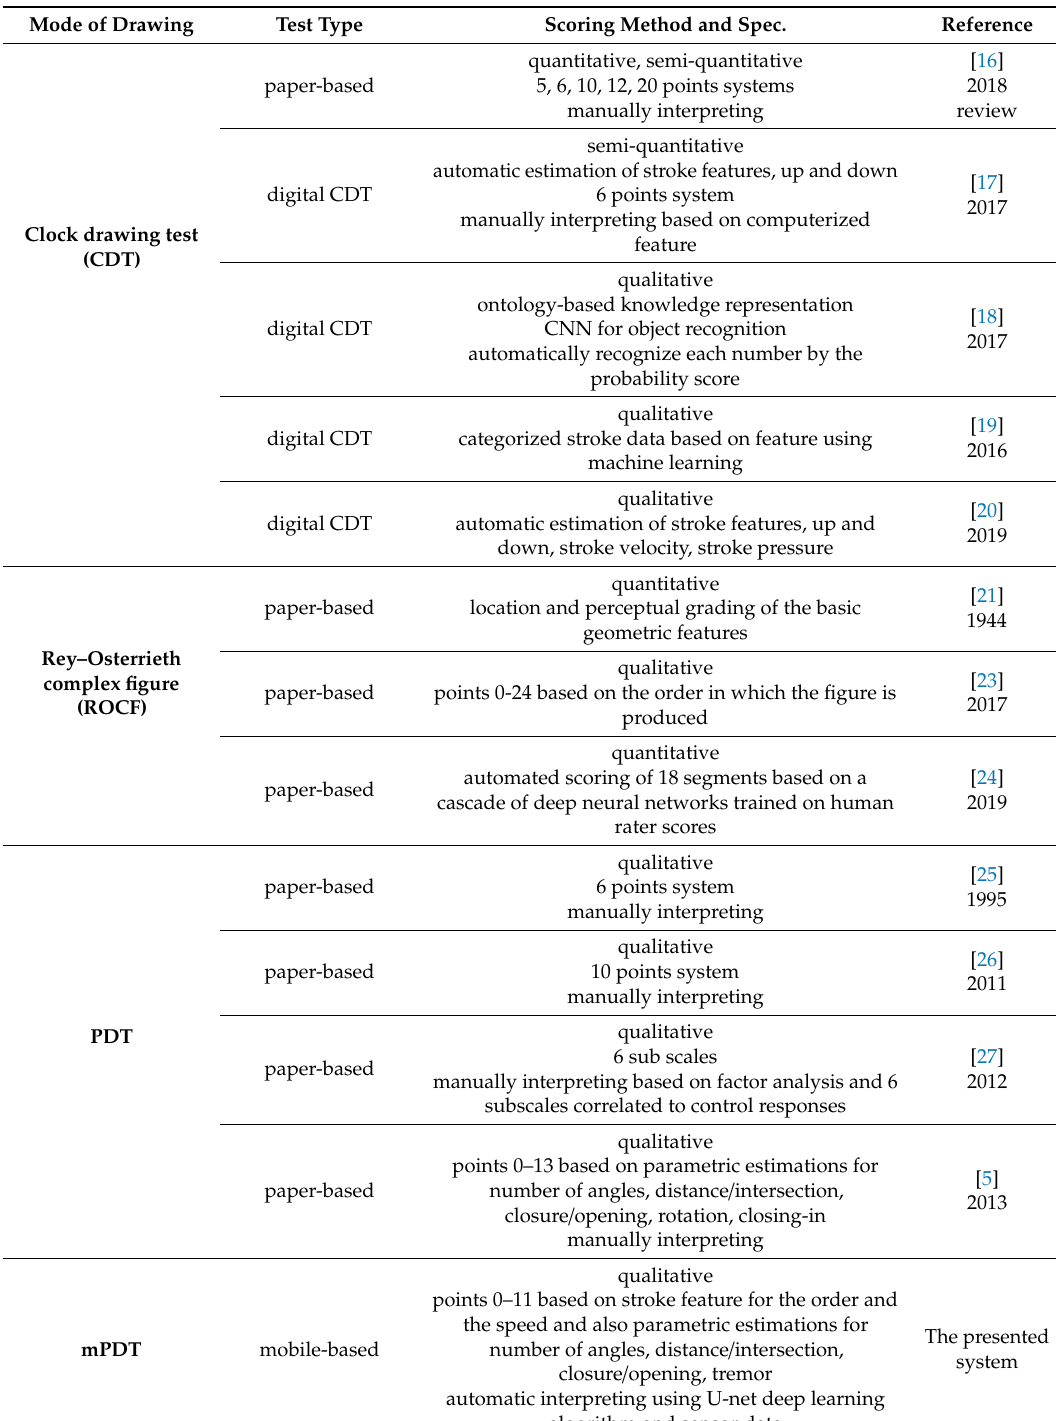
Table A1. Summary and comparison of the present study and the existing